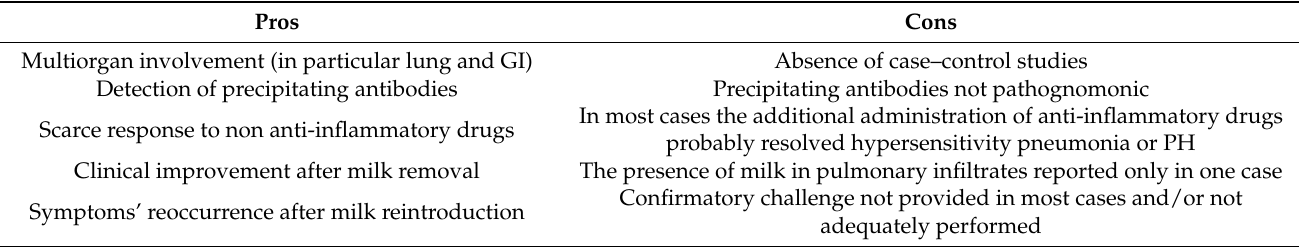
Table 3. The real existence of Heiner syndrome: pros and